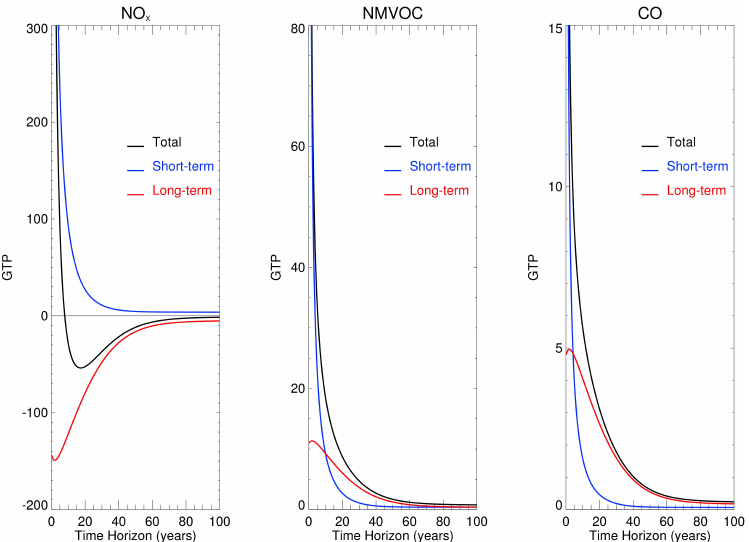
Fig. 3. GTPs as functions of time horizon for emissions of NO x , NMVOC and CO from all 4 continents combined. The short and long-term components are also shown.